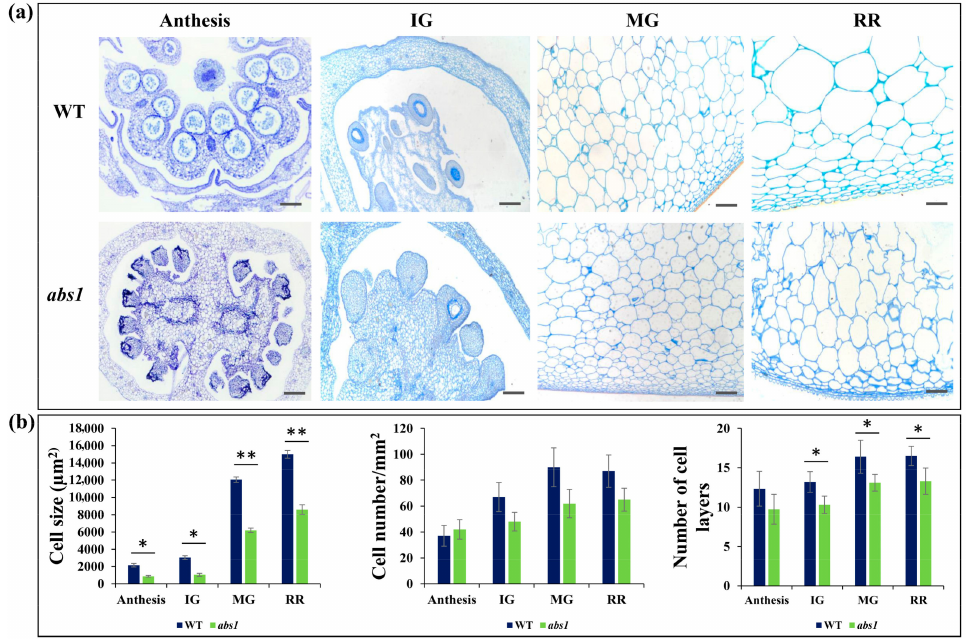
Figure 5. The microscopic observations of WT and abs1 fruits. ( a ) Pericarp cross-section of the fruits of WT and abs1 mutant plants at different maturity stages; anthesis, immature green (IG), mature green (MG), fully red ripe (RR). ( b ) The average cell size, number of cells, and number of cell layers were calculated using ImageJ. Bars = 100 µ m. The error bar represents the standard error. Asterisks indicate significant differences (*: p ≤ 0.05, **: p ≤ 0.01, Student’s t